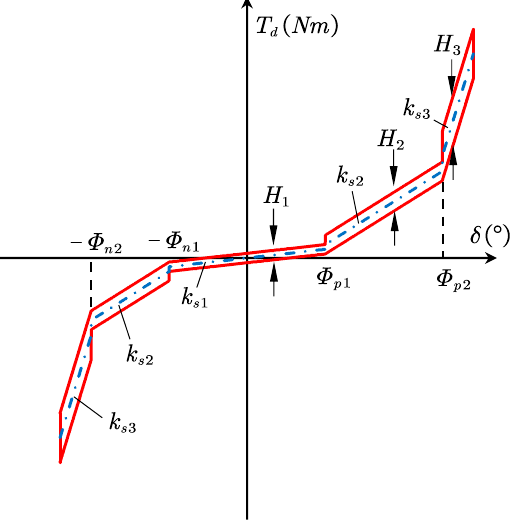
Figure 4. The piecewise-linear torsional characteristics of the three-stage clutch damper.